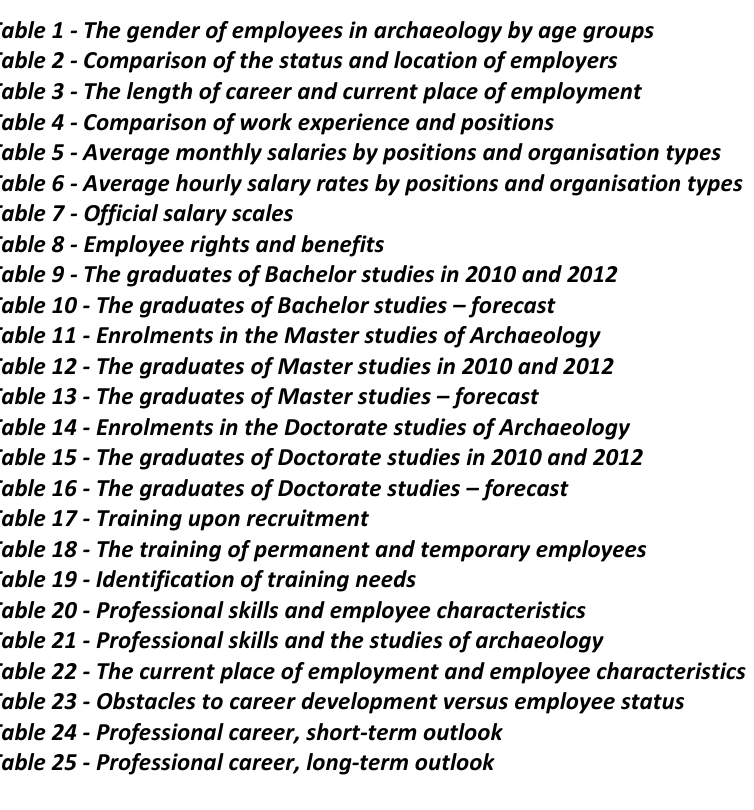
Figure 1 - Electronic answers Figure 2 - The age of employees Figure 3 – The nationality of employees in archaeology 23 Figure 4 - The share of employees with special needs 24 Figure 5 - The geographical location of employers and locations of work 26 Figure 6 - Educational level and studies 28 Figure 7 - Studies abroad 28 Figure 8 - Work experience in archaeology 30 Figure 9 - Archaeological functions Figure 10 - Support functions to archaeology Figure 11 - Types of employment in the field of archaeology Figure 12 - Types of official salary scales Figure 13 - Supplementary salary Figure 14 - Paid and unpaid study leave 39 Figure 15 - Training at the current place of employment 50 Figure 16 - The level of professional skills upon recruitment at the current place of employment 51 Figure 17 - Types of supplementary training Figure 18 - The training of permanent and temporary employees 54 Figure 19 - The training and development of employees 55 Figure 20 - The studies of archaeology versus professional requirements 59 Figure 21 - Shortage of skills upon recruitment 60 Figure 22 - Shortage of skills in the support functions to archaeology 61 Figure 23 - Outsourced support functions 62 Figure 24 - Shortage of skills in archaeological